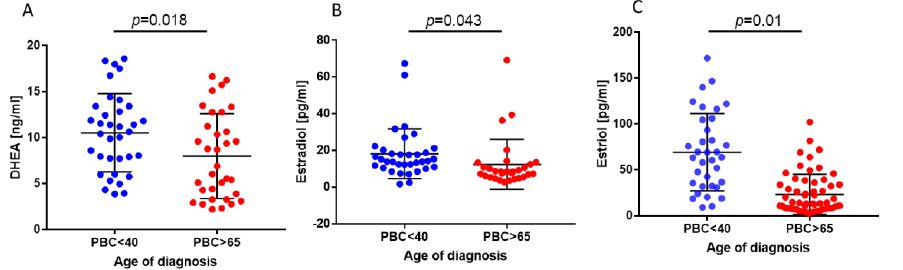
Figure 1. Reduced levels of DHEA, E2, and E3 in sera of female PBC patients at an age of diagnosis over 65. The levels of DHEA ( A ), E2 ( B ), and E3 ( C ) were measured using appropriate ELISA assays